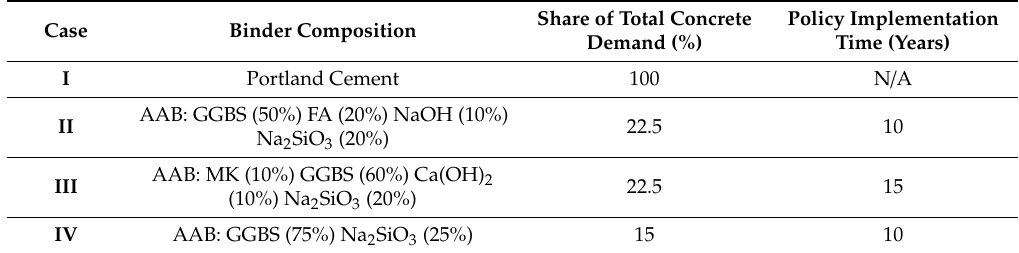
Table 4. Feasible AAB mixtures for futuristic scenarios.